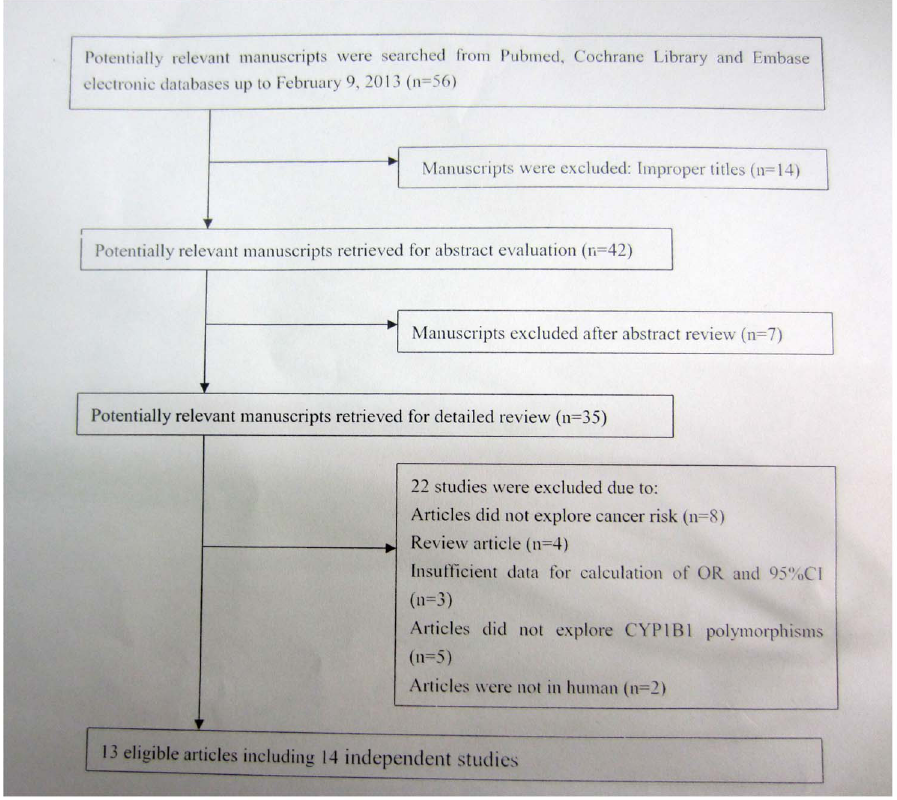
Figure 1. The flow diagram for the review process and outcomes of inclusion and exclusion. doi:10.1371/journal.pone.0068634.g001 PLOS ONE |